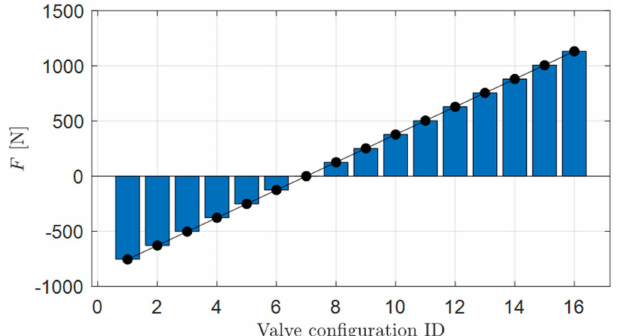
Figure 6. Effective force delivered by the hydraulic drive for different valve